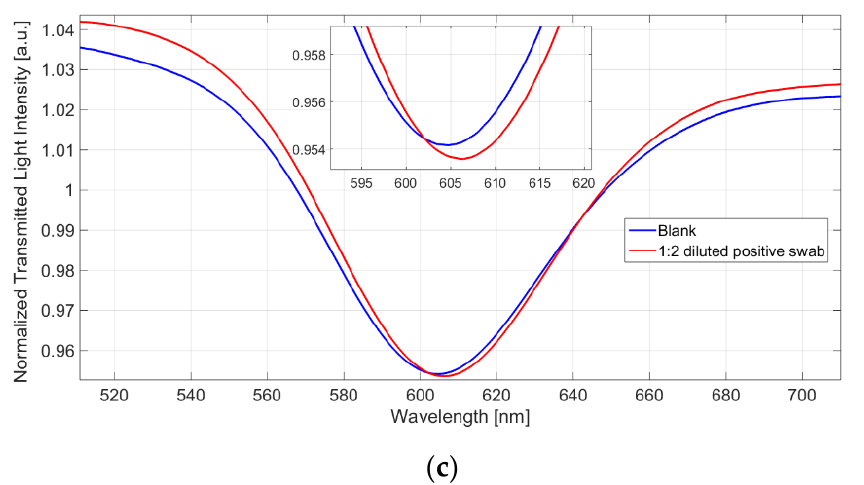
Figure 6. ( a ) Scheme of the POF’s gold surface derivatization based on aptamer SAM. ( b ) Transmis- sion spectra wide range and zoom (inset) for different SARS-CoV-2 spike protein concentrations (25 ÷ 1000 nM); ( c ) SPR spectra of the aptasensor at a SARS-CoV-2 positive swab in UTM 1:2 diluted with a physiological solution (0.9% NaCl) [4].